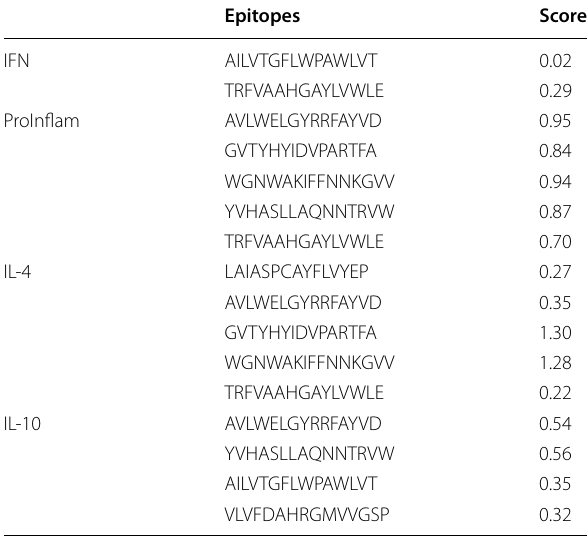
Table 2 Predicted IFN‑γ inducer, IL‑4Pred, and ProInflam‑ inducing epitopes